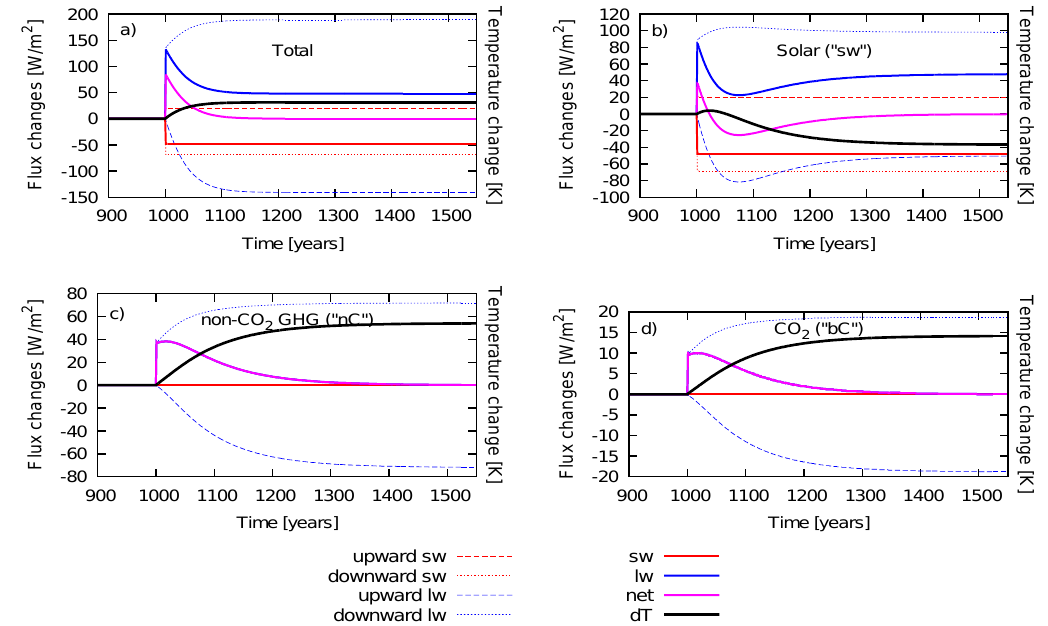
Fig. 3. Evolution of flux changes (Wm − 2 ) (coloured lines) and temperature changes (K) (black line) in the experiment, where the shortwave and longwave absorption is zero during the spin-up time (1000yr) and then set to the “full atmosphere” values ( a s = 0 . 2 and a l = 0 . 77). Shortwave fluxes are shown in red, longwave in blue. Upward (negative) and downward (positive) fluxes are dashed and dotted, respectively. The total net-flux changes are shown as a purple solid line. Changes are shown for the total flux and temperature changes (a) and the individual tagging categories: “sw” (b) , “nC” (c) , and “bC” (d) .